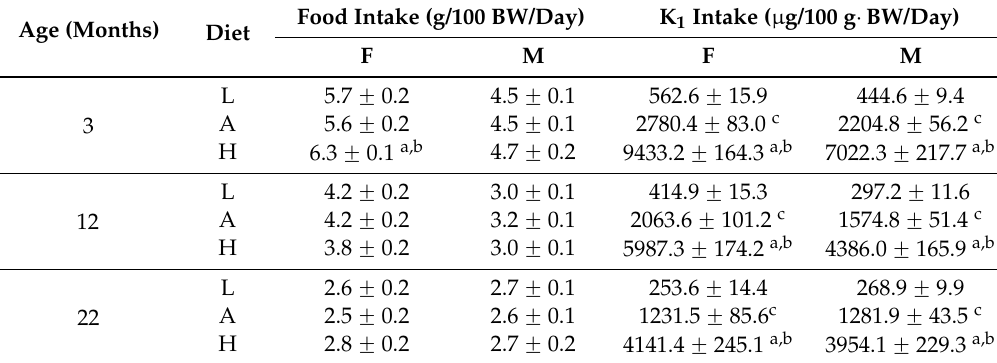
Table 1. Daily food (g/100 g body weight (BW)) and K 1 ( µ g/100 g ¨ BW) intakes of 3-, 12-, and 22-month-old male (M) and female (F) Sprague–Dawley rats fed the low (L), adequate (A) or high (H) diets throughout their